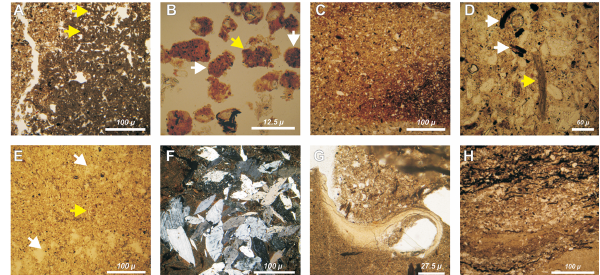
Fig. 5. Puente El Zampal (PEZ) locality: photomicrographs of micromorphological features (PPL: plane polarized light. XPL: crossed polarized light). (A) Calcitic concentration feature and spongy microstructure (arrows) (sample: PEZ 12, PPL). (B) Spher- ical, bacillo-cylinder (white arrows) and irregular (yellow arrow) excrement pedofeatures infilling a void (sample: PEZ 11, PPL). (C) Ferruginous impregnation in the soil mass (sample: PEZ 10, PPL). (D) Unidentified particles of organic matter (white arrows) and a tissue residue (yellow arrow) (sample: PEZ 8, PPL). (E) Con- centric clay coating in a void (yellow arrow) and spongy microstruc- ture in the bottom/right upper areas of the thin section (white ar- rows) (sample: PEZ 9, PPL). (F) Gypsum crystals aggregate (sam- ple: PEZ 4, XPL). (G) Chamber clay infill (sample: PEZ 11, PPL). (H) Plant residues included into different grain size sedimentary layers (sample: PEZ 2,